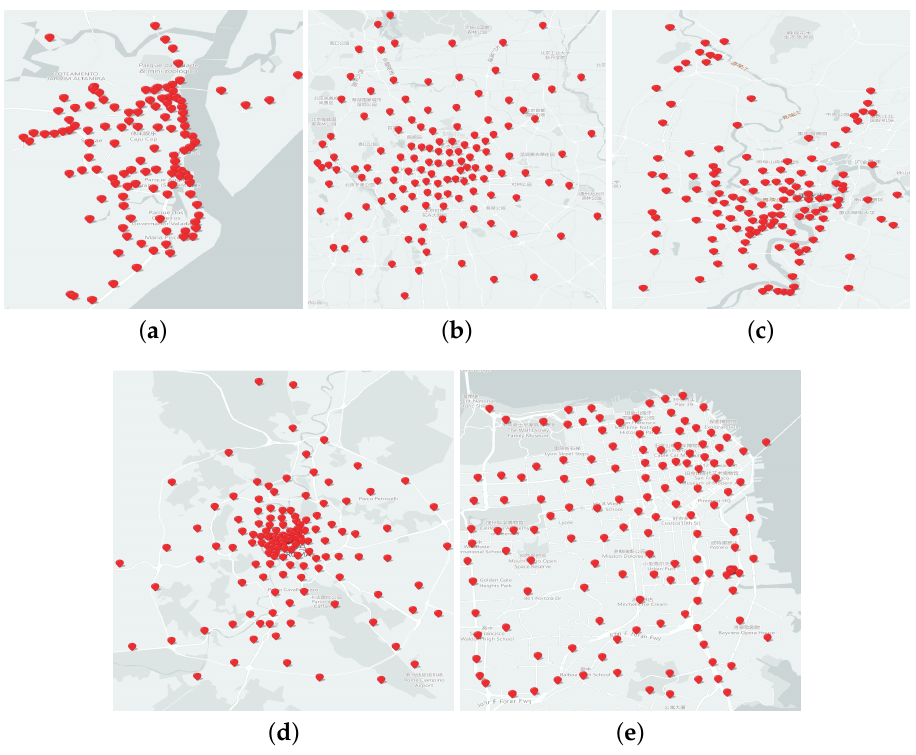
Figure 18. The urban hotspots captured by the PSOWK algorithm. ( a ) Aracaju; ( b ) Beijing; ( c ) Chongqing; ( d ) Roma; ( e ) San Francisco.